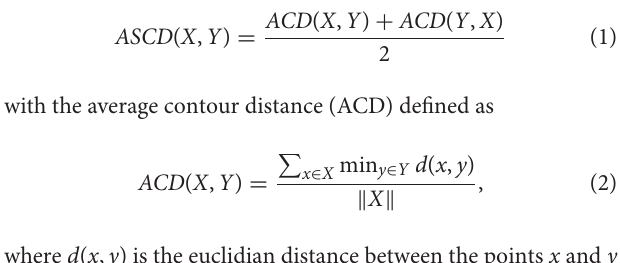
using a 10-fold Monte Carlo crossvalidation (80% train, 20% test) on D US and D Lf , while once again D aux